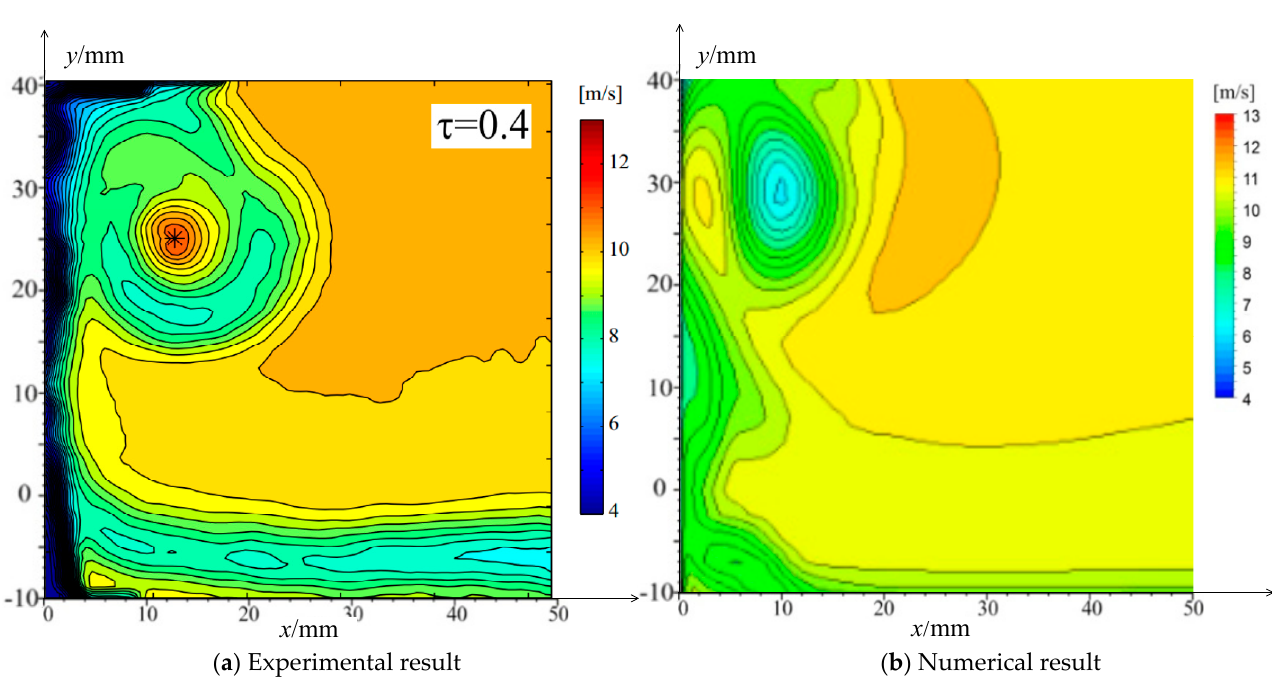
Figure 4. Comparison of vortex in experimental and numerical results.